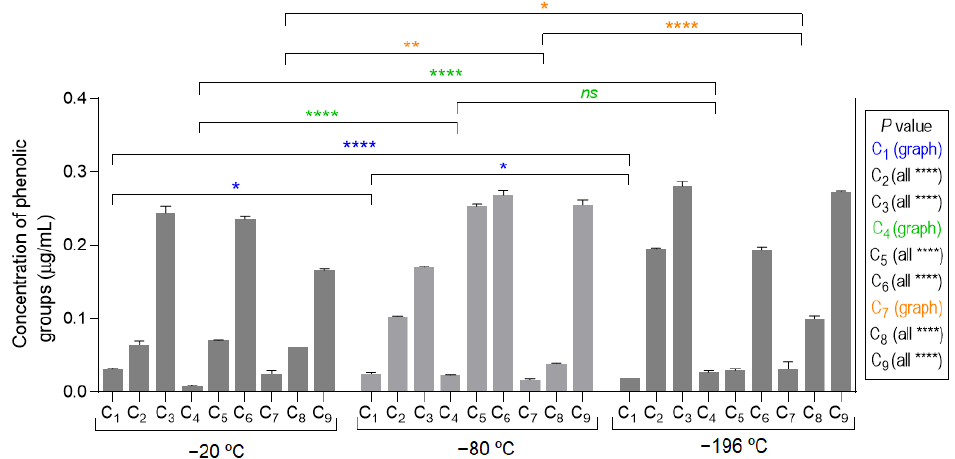
Figure 4. Assessment of antioxidant activity of marine origin cryogels (C 1 to C 9 , produced at − 20, − 80, and − 196 °C) by the quantification of phenolic groups. All samples (comparing the different temperatures) showed statistical significance of **** p < 0.0001 except those represented with the symbols of * ( p < 0.05), ** ( p < 0.01), and ns (not significant).